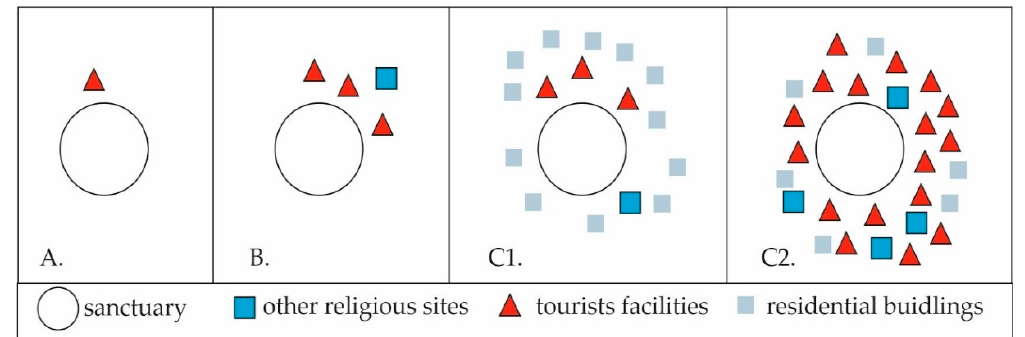
Figure 3 . Types of sanctuary service zones: ( A ) initial; ( B ) mixed (dispersed); ( C ) compact: ( C1 ) linear zones and ( C2 ) districts .